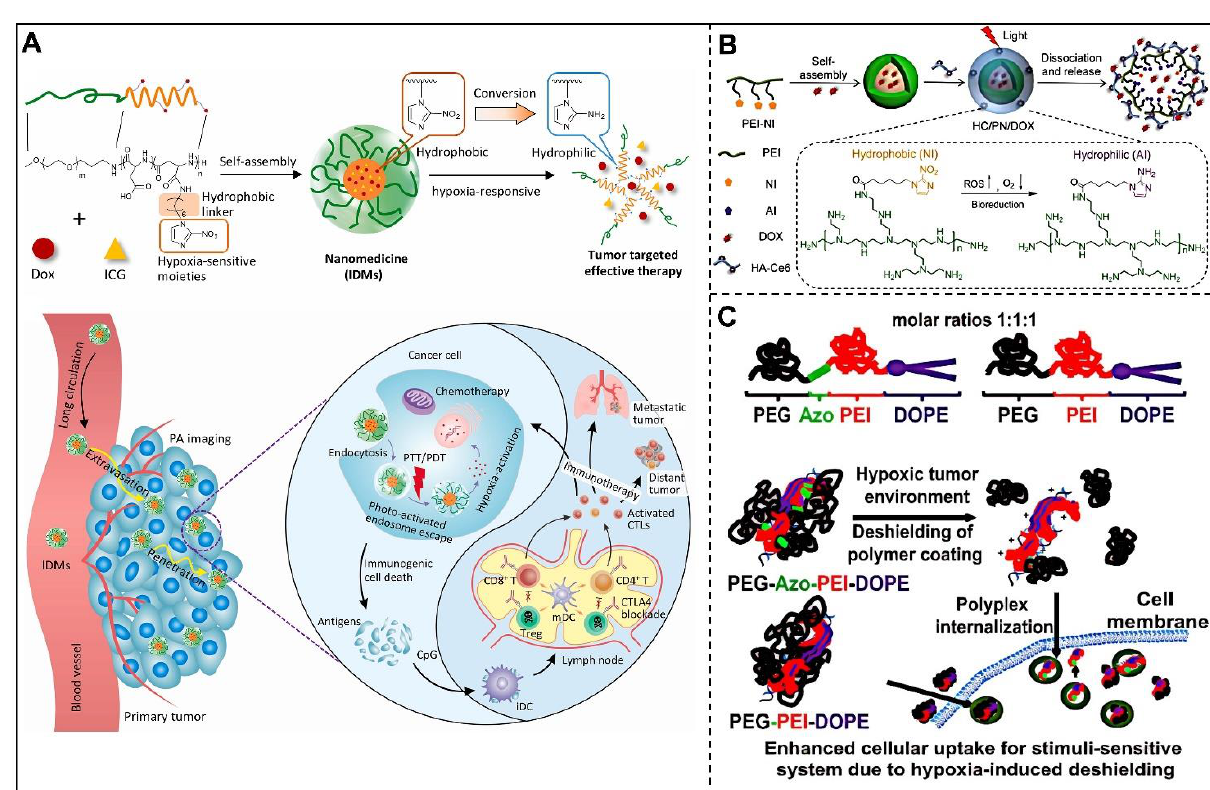
Figure 4. Design and responsive mechanism of hypoxia-triggered srNPs. ( A ) Preparation and in vivo selectively hypoxia-activated mechanism of IDMs nanomedicines for eradicating advanced breast cancer. Reproduced with permission [99]. Copyright 2021, Elsevier. ( B ) Chemical structure and hypoxia-responsive mechanism of NI-based nanoparticles. Reproduced with permission [98]. Copyright 2018, Royal Society of Chemistry. ( C ) Schematic illustration of synthesized polymers and their mechanism of hypoxia-responsive disintegration in the TME. Reproduced with permission [100]. Copyright 2014, Wiley-VCH GmbH.